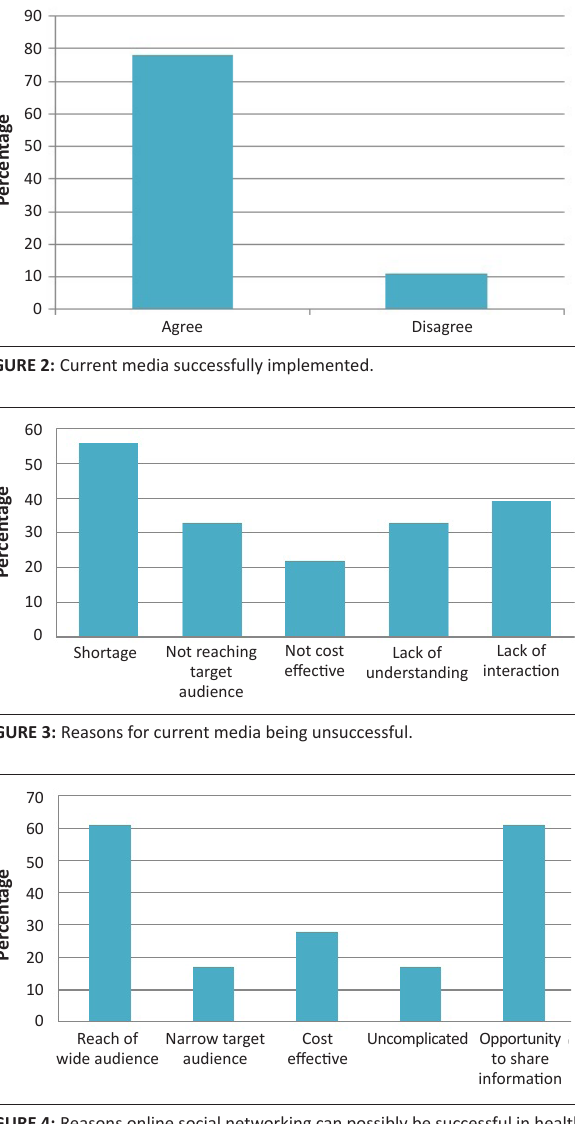
FIGURE 4: Reasons online social networking can possibly be successful in health promotion